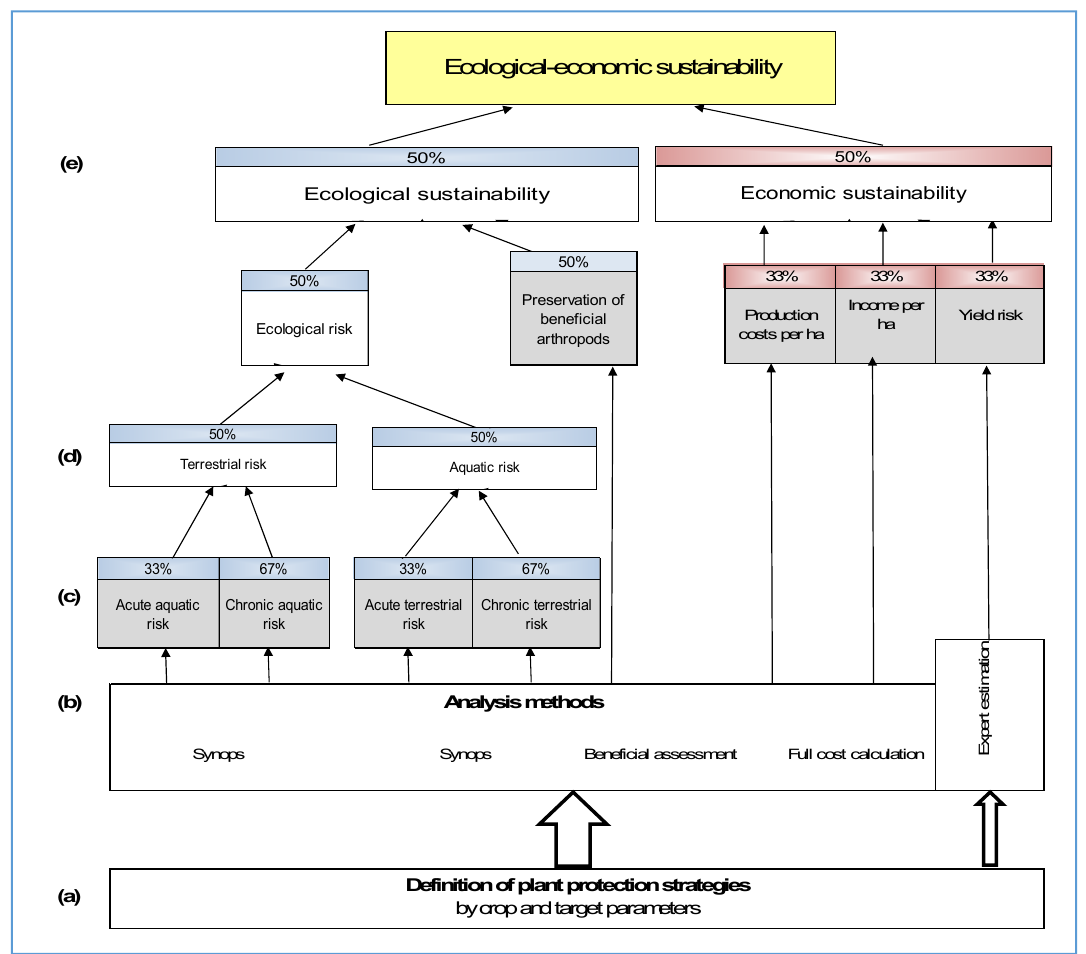
Figure 1. Five-step scheme ( a – e ) of sustainability assessment for plant protection strategies in winter wheat and table potato production (Adapted from